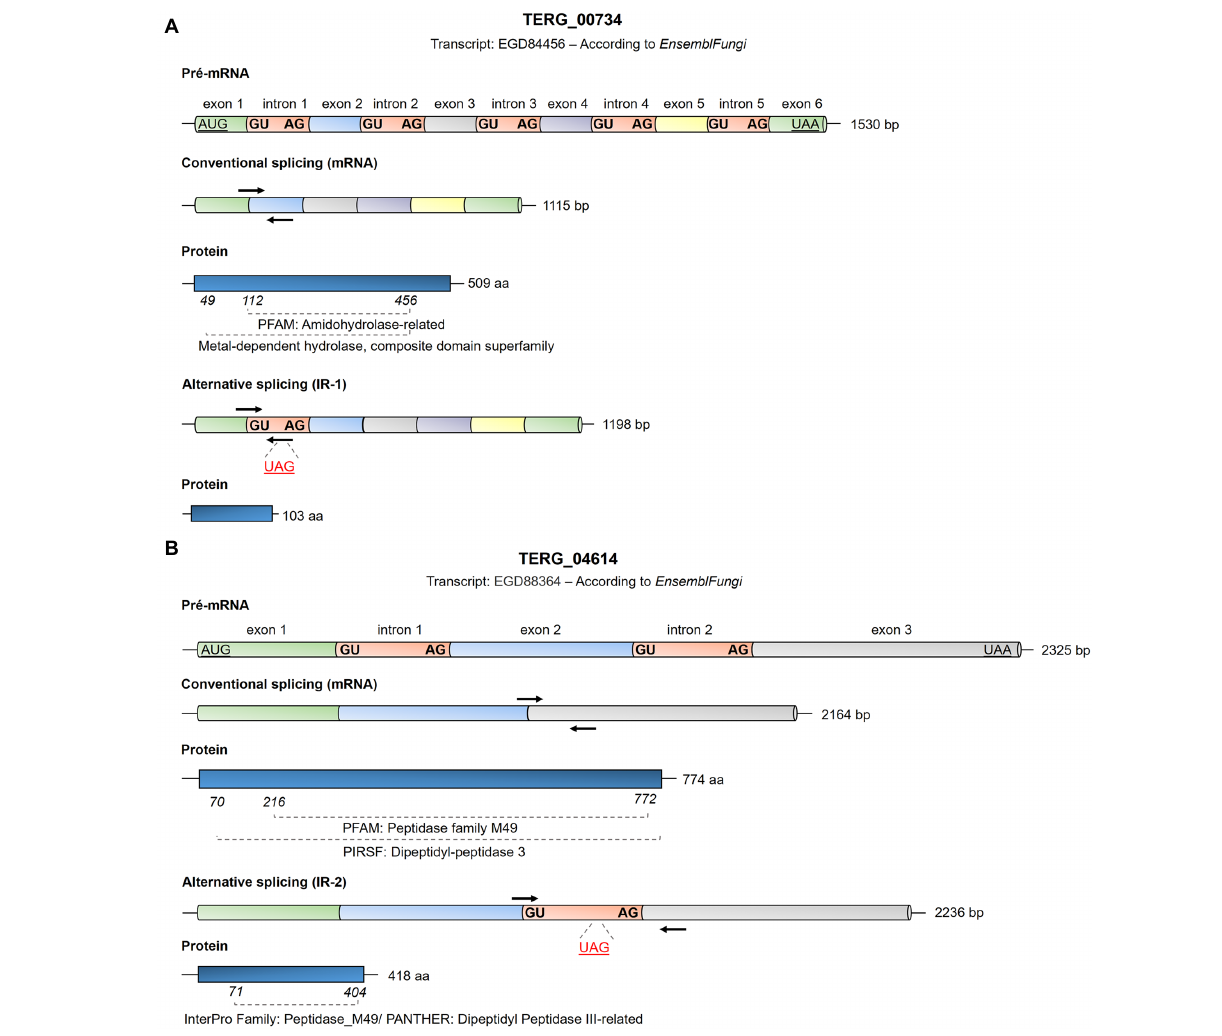
FIGURE 1 | Schematic representation of the Trichophyton rubrum EGD84456 transcripts from TERG_00734 (A) and EGD88364 transcripts from TERG_04614 (B) based on the analysis using EnsemblFungi (https://fungi.ensembl.org/index.html). The conventional and alternative splicing events expected for these transcripts are shown as are the first and last nucleotides of each intron sequence. Initiation and termination codons are represented as underlying characters. Intron splice sites for each intron are highlighted in bold. Black arrows indicate primer annealing sites for transcript quantification by qPCR in this study in the mRNA panels. Details regarding the primers used in this study are provided in Supplementary Table S1 . In the alternative splicing panel, the stop codons in the introns are shown as underlying red characters, indicating the blockage of translation for the specified transcript. The length of exons and introns are represented just for illustrative purposes, as it does not correspond to the actual size of the